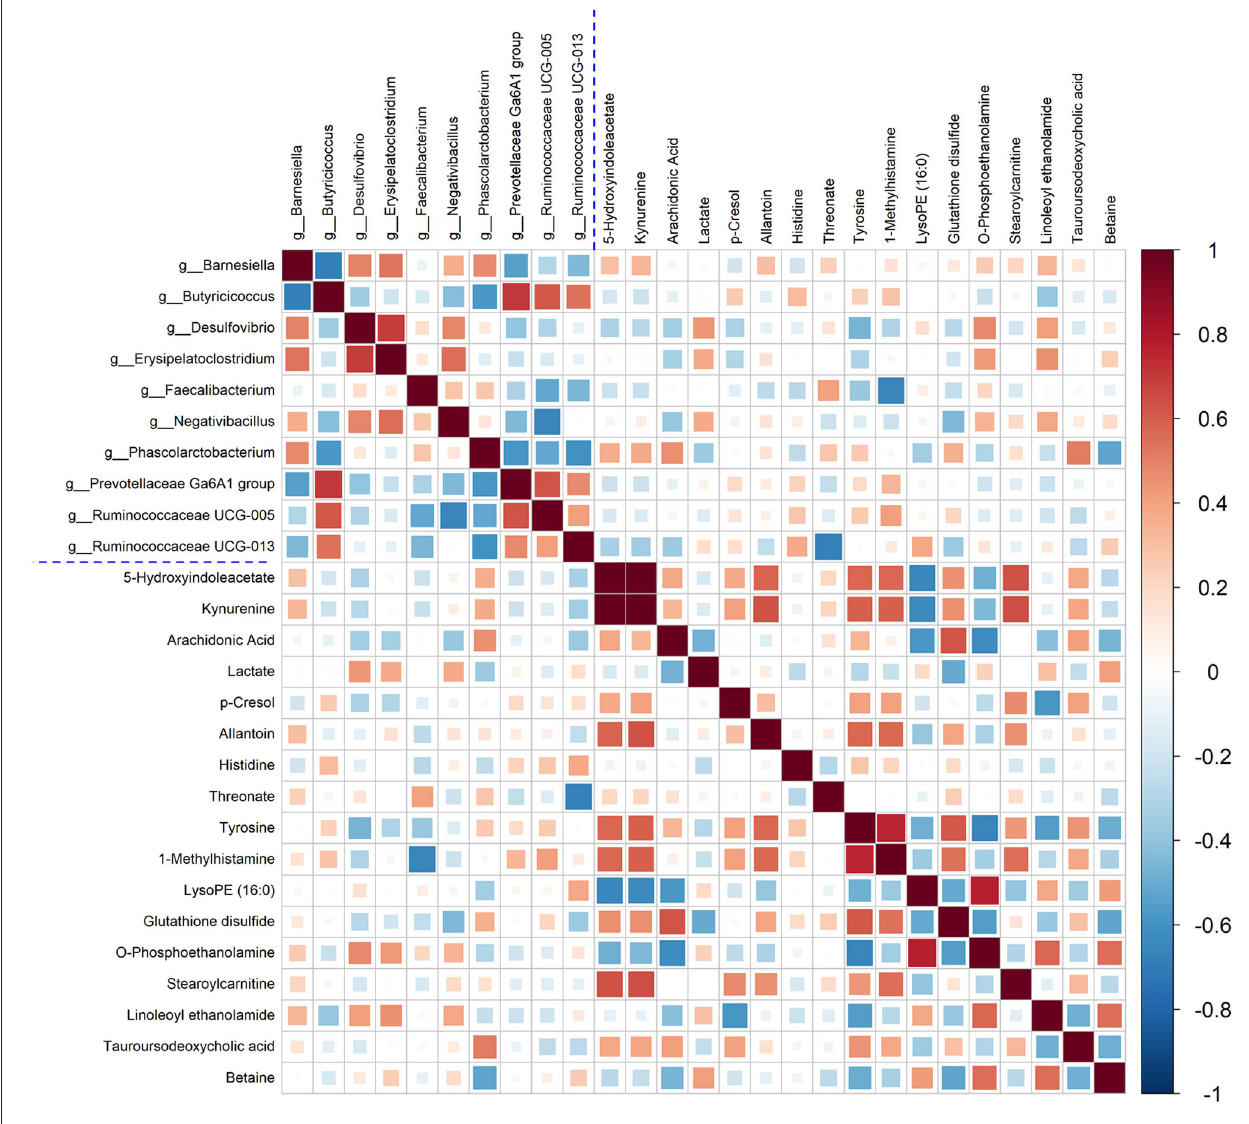
FIGURE 7 | Correlation between the significantly changed liver metabolites and microbial genera. Pearson correlation coefficients between liver metabolites and microbiota genera were color-coded, that hot color indicating positive correlations, whereas the cold denoting negative